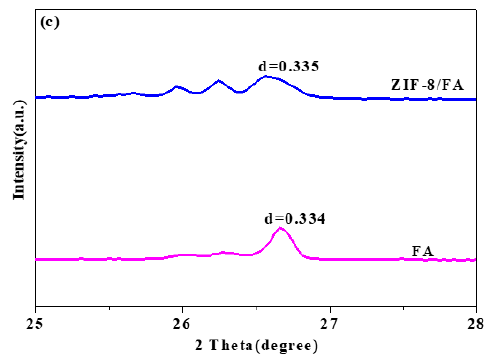
Figure 2. X-ray di ff raction (XRD) spectrum of ( a ) FA and ( b ), ( c ) ZIF-8 / FA composite. Figure 2. X-ray diffraction (XRD) spectrum of ( a ) FA and ( b ), ( c ) ZIF-8/FA composite.